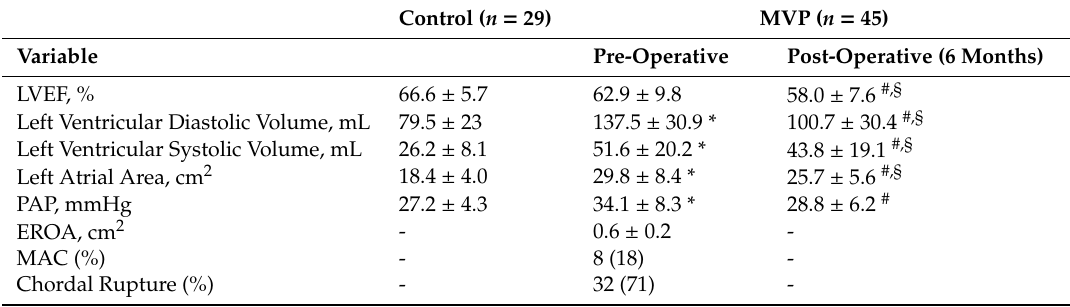
Table 2. Echocardiographic data of control subjects and patients that underwent mitral valve repair. Control ( n = 29) MVP ( n = 45) Variable Pre-Operative Post-Operative (6 Months) 66.6 ±